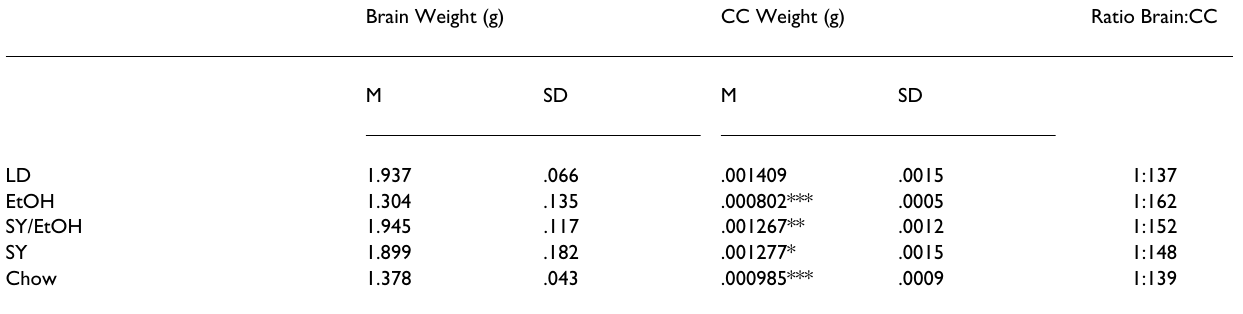
Table 2: Weight of Brain and Corpus Callosum and Brain:CC Ratio Brain Weight